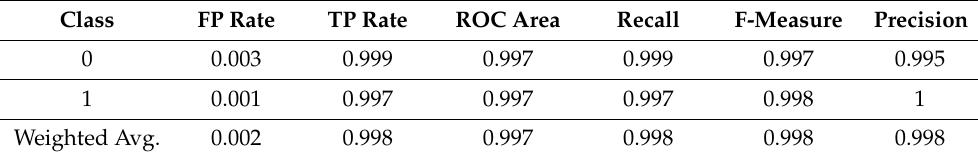
Table 4. Evaluation metrics for J48 DT.